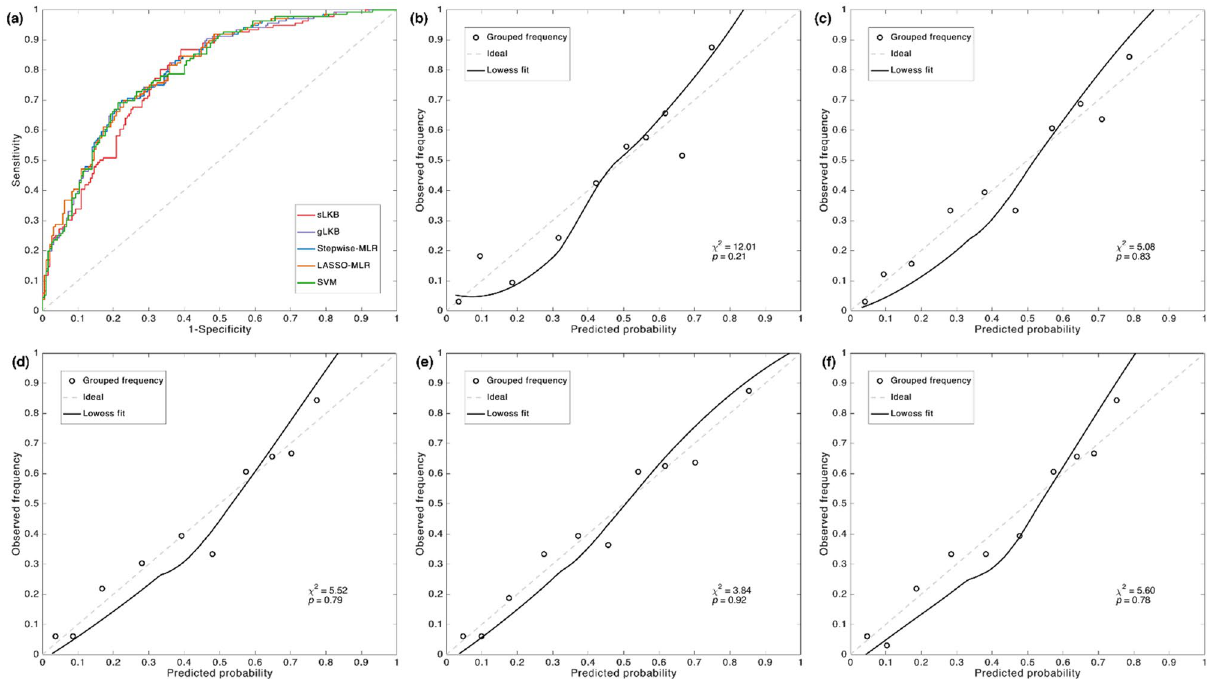
Figure 2. Receiver operator curves ( a ) and the calibration plot of actual outcome vs. predicted probability for the sLKB ( b ), gLKB ( c ), Stepwise-MLR ( d ), LASSO-MLR ( e ), and SVM ( f ) models. Results of the Hosmer– Lemeshow test are displayed in the lower right part of each plot. The open circles are the observed frequency in each group by the deciles of mean predicted probabilities. The dashed line represents the ideal prediction and the solid line is the loess fit for the output of the